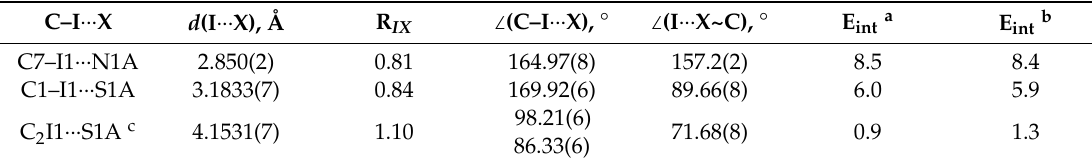
Table 1. Parameters of halogen bonding (XB) in 1 .